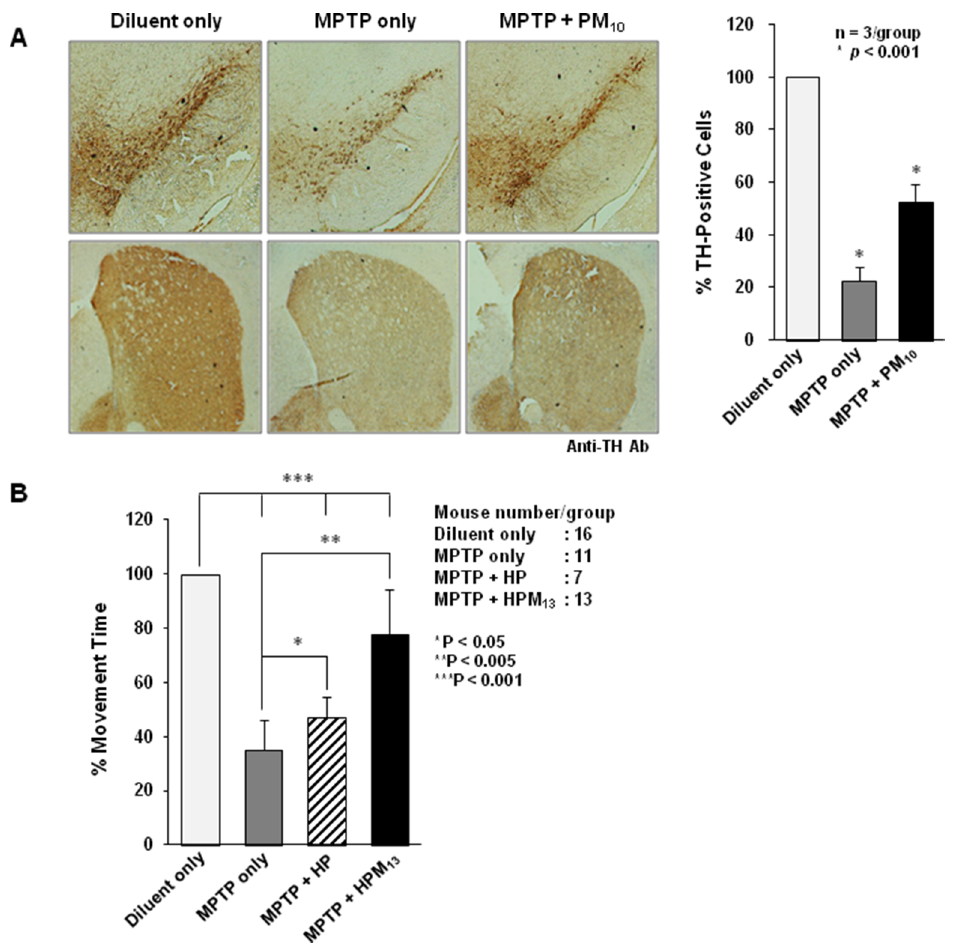
Figure 6. CP-Parkin reduces acute MPTP-induced neurotoxicity and preserves motor function. ( A ) PM 10 Reduces MPTP-induced dopaminergic toxicity. MPTM-lesioned mice were treated with PM 10 for 5 days as shown in Figure 5A (IP, 10 mg/kg) and loss/preservation of dopaminergic neurons was determined by tyrosine hydroxylase (TH) staining (left panel). ( B ) HPM 13 preserves gross motor function of MPTM- lesioned mice. 9 hrs after the last MPTP treatment (Figure 5A) mice were treated for 3 hrs with 200 m g proteins (IP, HP or HPM 13 ), and motor ability was assessed by placing the animals in a water bath and video recording subsequent movements. The percentage of time of the mice in each treatment group were engaged in 4 legged motion is presented as means 6 S.D. The number of mice in each group was as follows: Diluent, 16; MPTP only, 11; MPTP + HP, 7; MPTP + HPM 13 , 13. Experimental differences between groups were assessed by ANOVA (* p , 0.05, ** p , 0.005, *** p , 0.001).